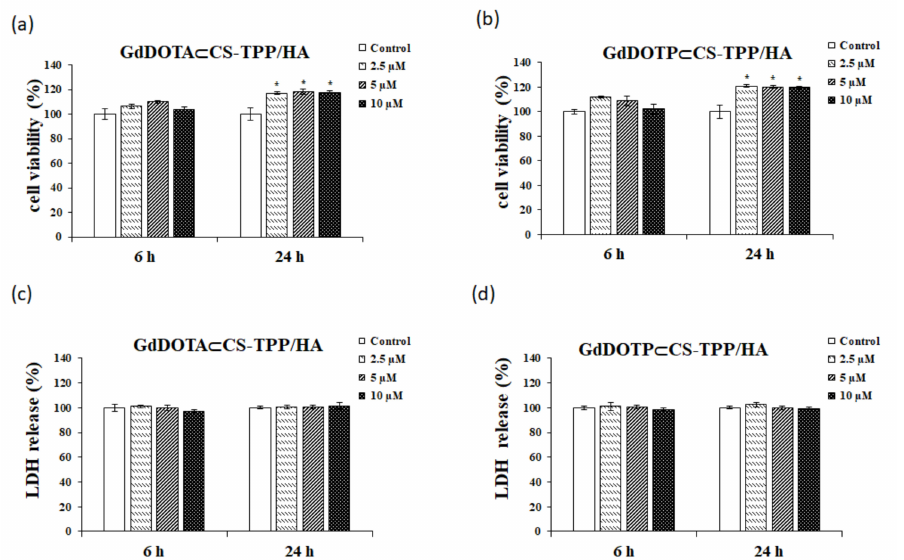
Figure 1. The MTT ( a , b ) and LDH ( c , d ) assays in presence of RAW 264.7 cells after 6- and 24 h exposed to doses of 2.5, 5 and 10 µ M of ( a , c ) GdDOTA ⊂ CS-TPP/HA and ( b , d ) GdDOTP ⊂ CS-TPP/HA NGs. Untreated cells were used as a control. Data are expressed as mean ± SD ( n = 3). The asterisks represent the statistical significance obtained by the Student’s test, as follows: * p < 0.05 (significant). The integrity of the cell membrane was evaluated by the LDH test (Figure 1c,d). The data obtained show that, throughout the treatment duration (24 h), both GdDOTA ⊂ CS- TPP/HA and GdDOTP ⊂ CS-TPP/HA at doses between 2.5 and 10 µ M did not induce